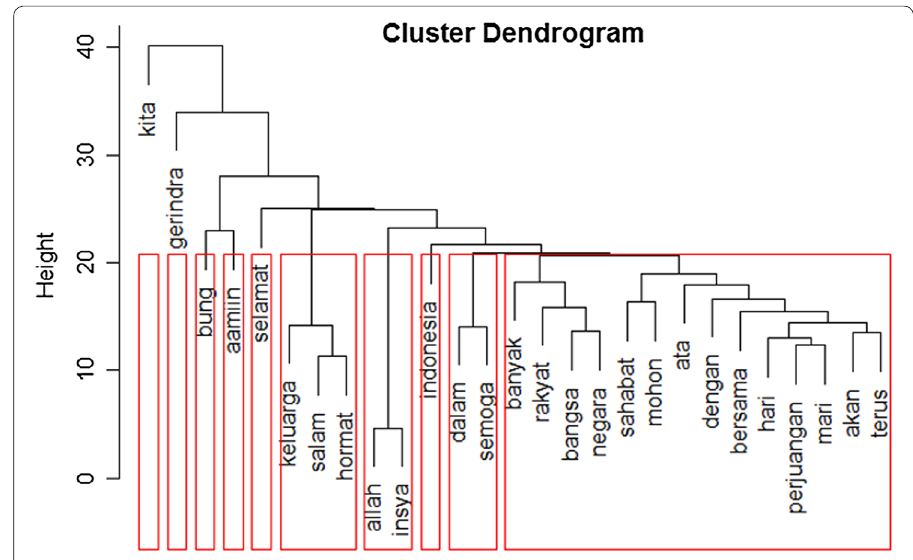
Fig. 5 Dendogram result of Prabowo’s tweet, he likes to use the word “Kita” (“We”), his party named “Gerindra” and the word “Bung” (“Man”) for patriotism